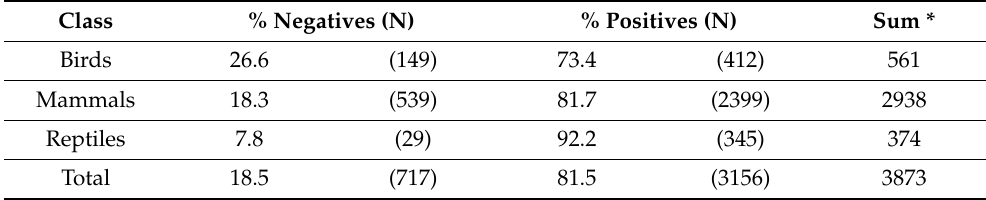
Table 1. Number of samples according to the microbiological testing